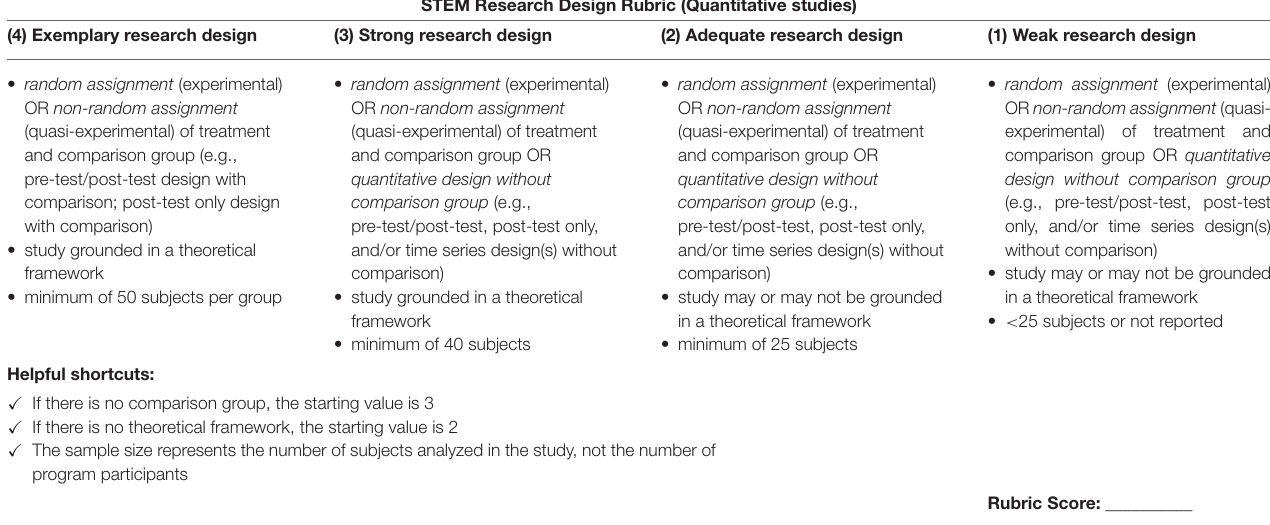
TABLE 2 | STEM research design rubric for quantitative